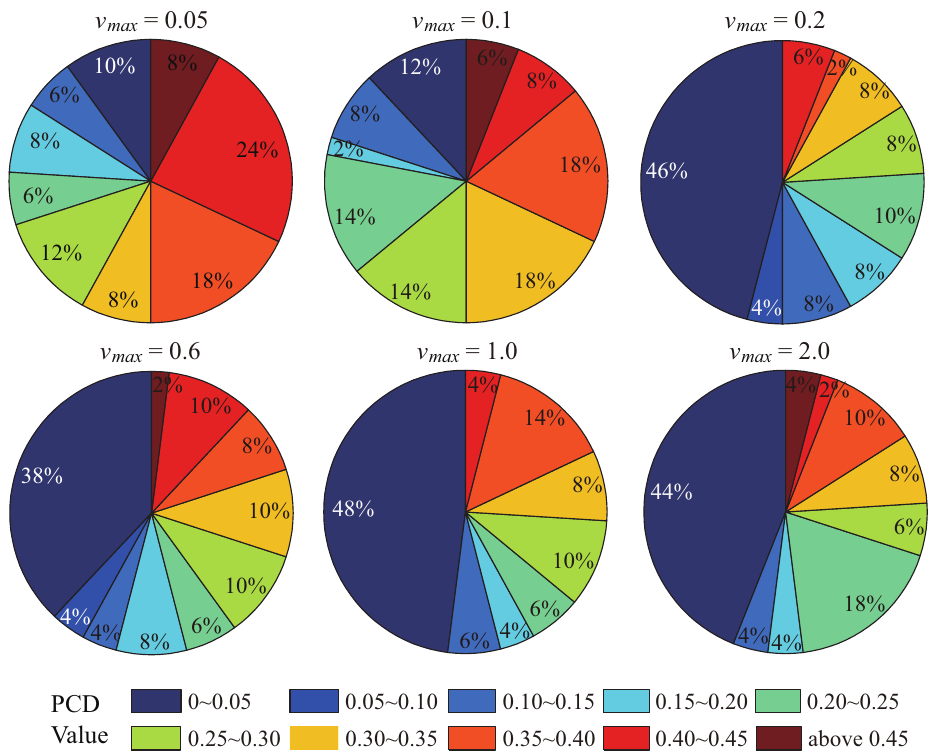
Figure 4. Corresponding possibilities of the final PCD value for different values of v max